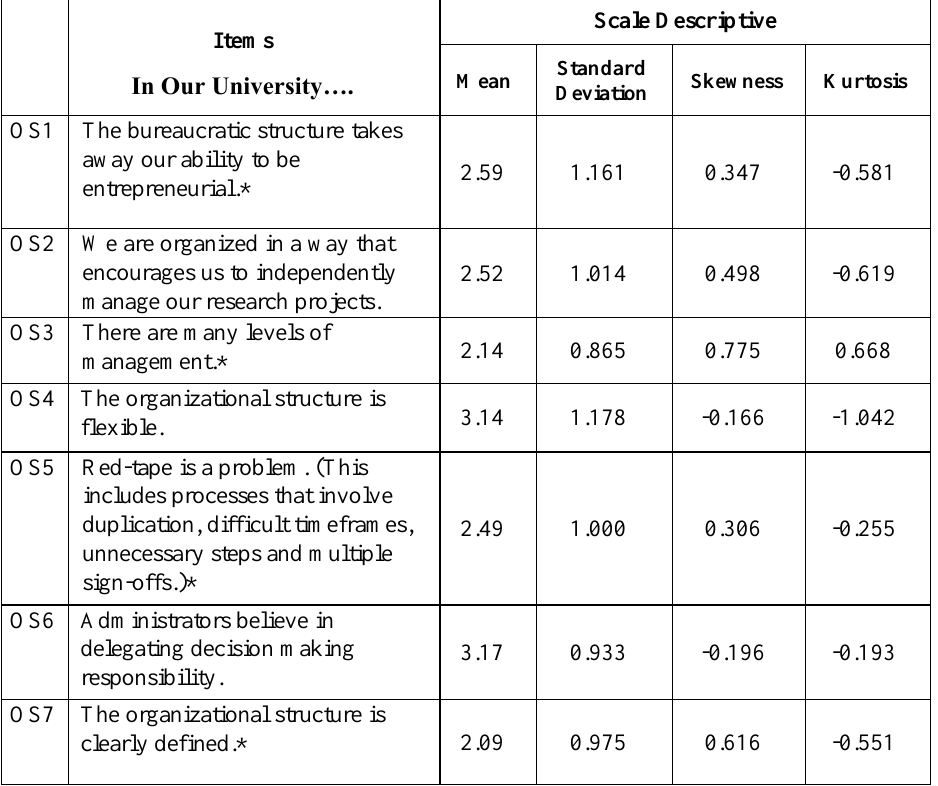
Table 03: Measures of Organizational Structure Items In Our University….